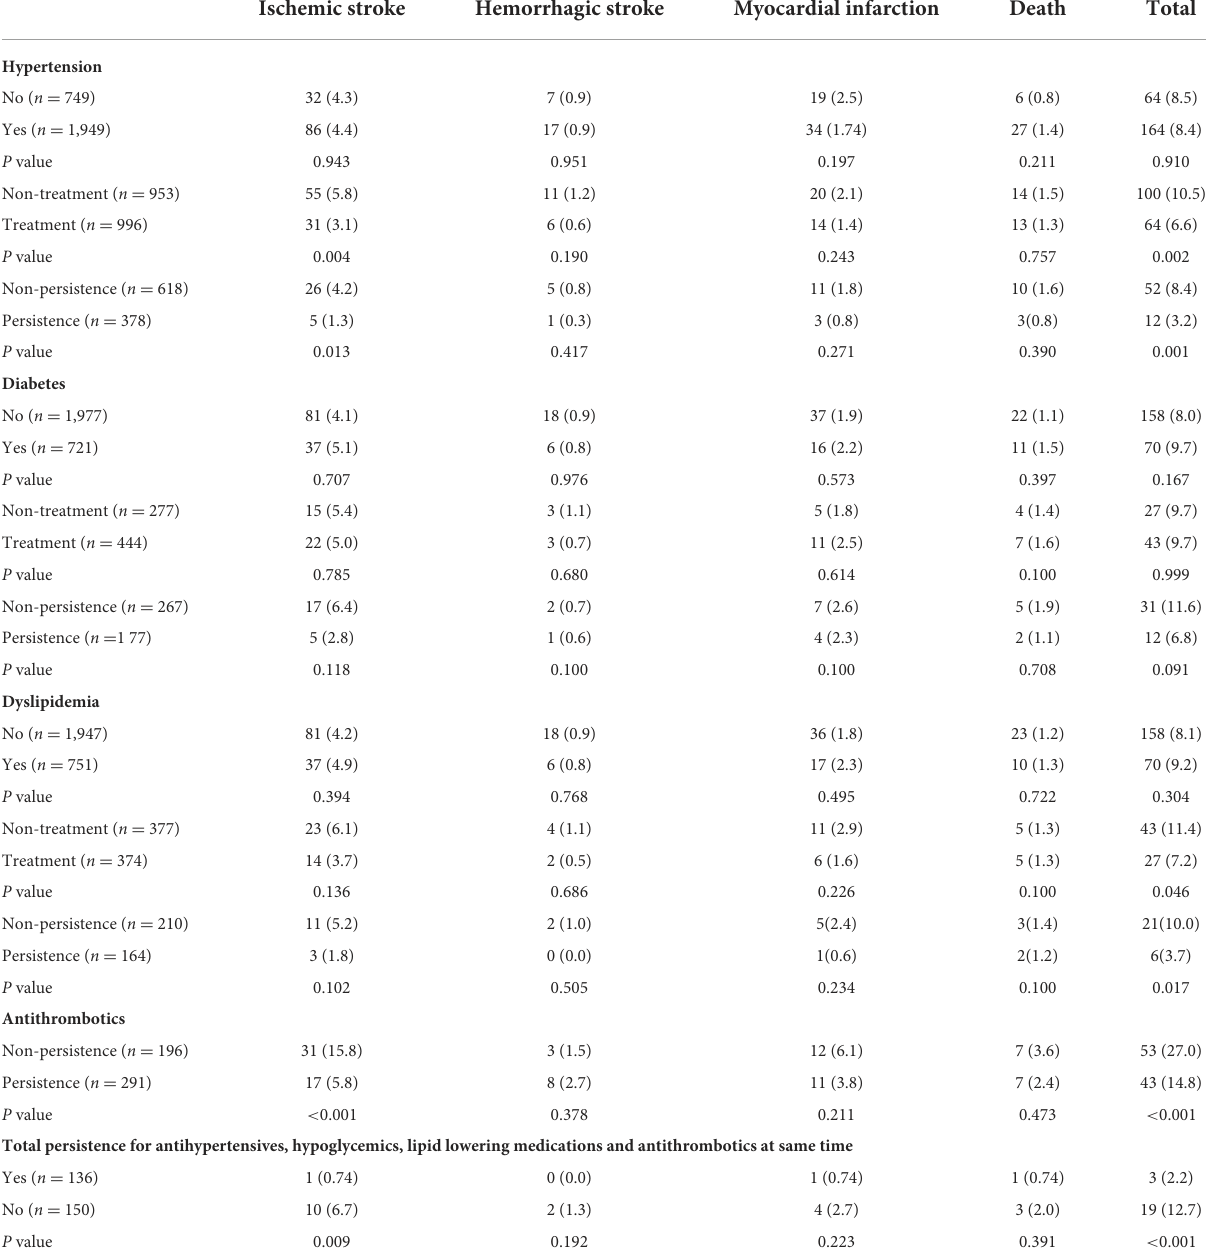
TABLE 4 Persistence of drug therapy with outcomes ( n , %). Ischemic stroke Hemorrhagic stroke Myocardial